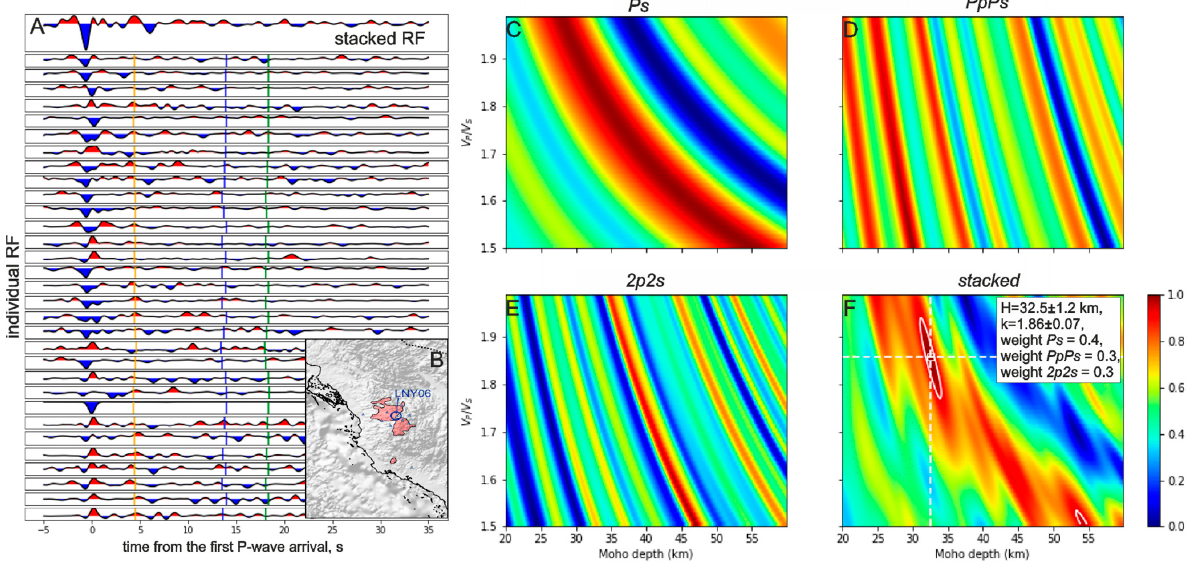
Figure 6. Results of the H-k stacking for the station LNY06 located in the center of Harrat–Lunayyir exactly above the area of seismic unrest that occurred in 2009, which is presumed to be due to the magma intrusion. ( A ): Individual receiver functions (Q-component). The upper trace is the average of all traces. Red, blue, and green hatches mark the theoretical arrivals of the Ps , PpPs and 2p2s phases, respectively. ( B ). The location of the station on the map. ( C – E ): Grid search results for three individual phases Ps , PpPs and 2p2s . ( F ): Result of stacking of the results for all phases. The white dashed lines mark the best solution. The parameters of stacking and results for H and k determination are shown on the panel F.